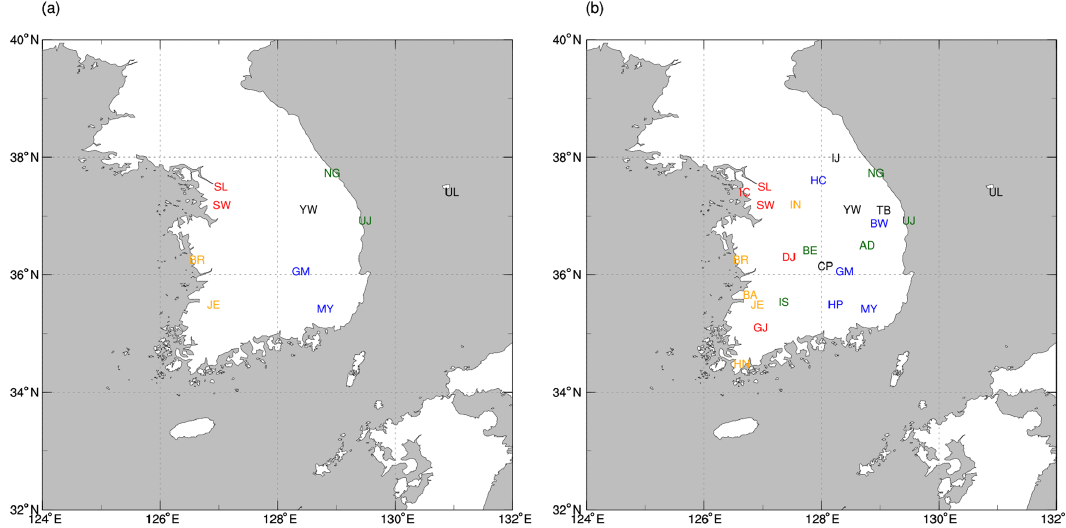
Figure 3. Stations used for experiments (a) OPT_5 and (b) OPT_W, CNTL, VRF_5, and VRF_6. Different colors in the station abbreviations represent different LCTs: DBF (black), MF (blue), WS (green), CL (yellow), and UB (red). See Table 1 for the abbreviations of the stations and